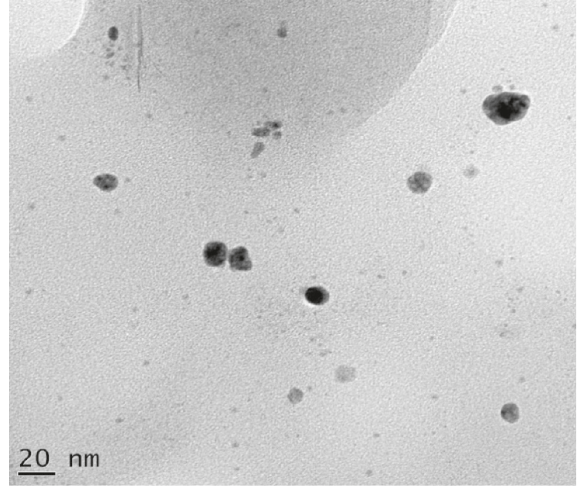
Figure 11: Morphological stability of silver nanoparticles after degradation of